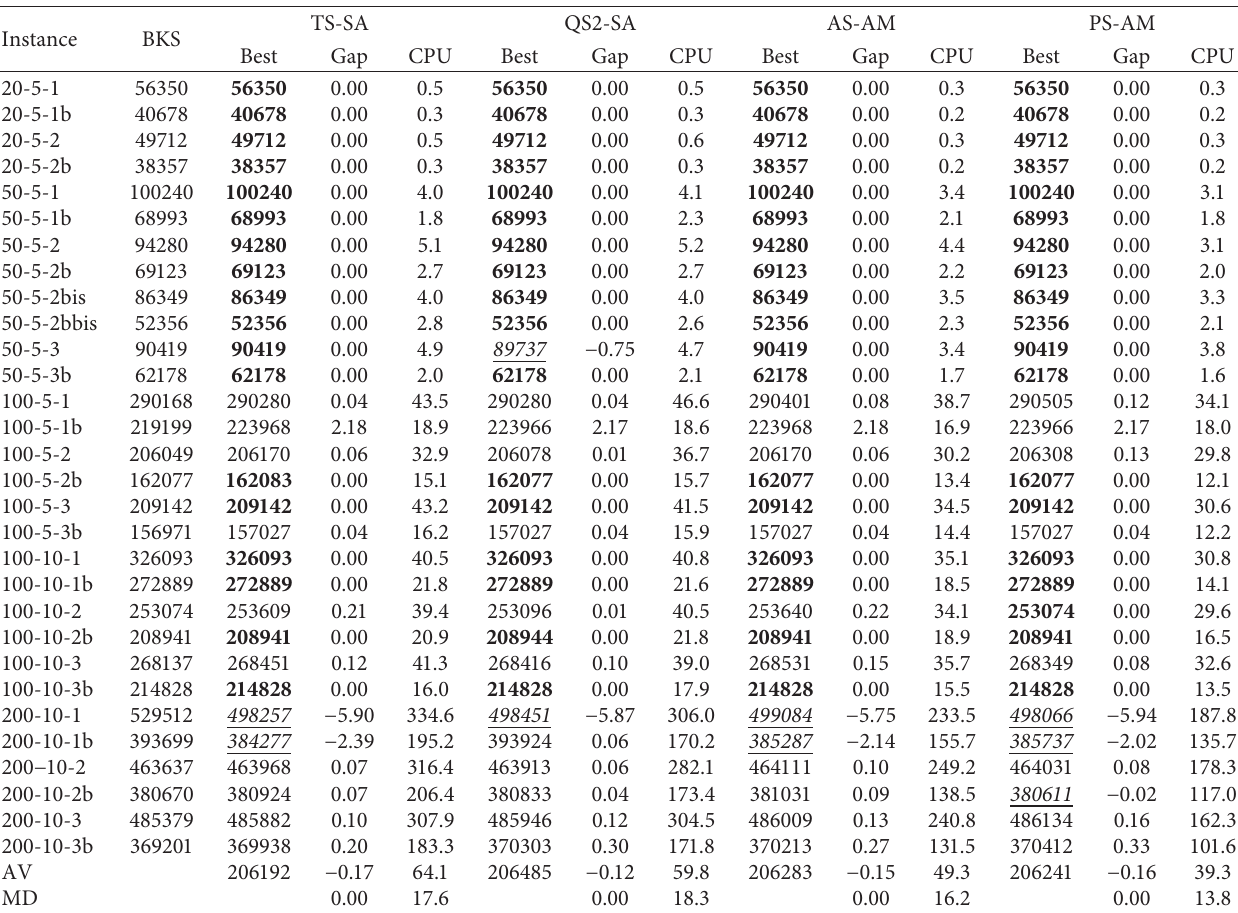
Table 9: Results for the CLRPSPD instances in Prins